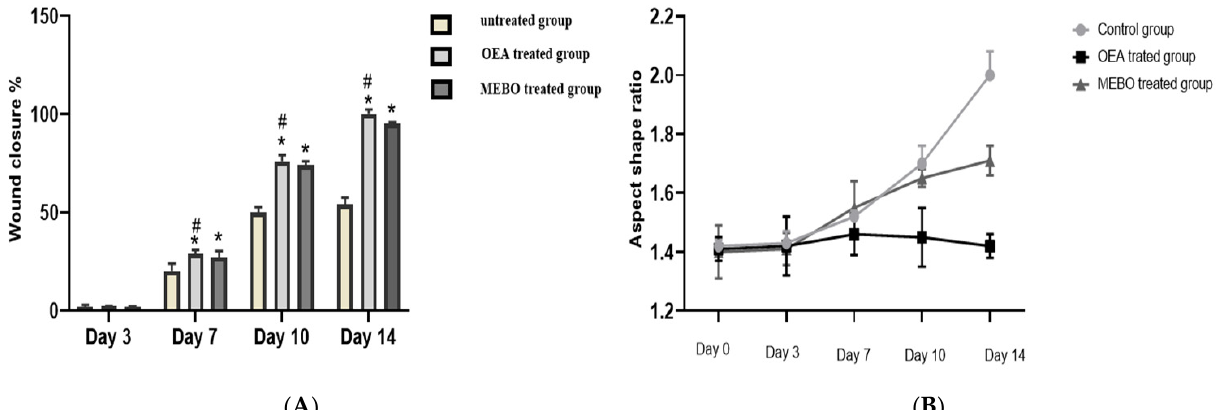
Figure 6. ( A ) Percentages of wound closure in all groups of the study ( n = 6) with time after injury (0, 3, 7, 10, and 14 days). A two-way ANOVA test was performed to evaluate whether there was a significant difference between the groups. The data is presented as the mean ± SD. * p < 0.05 compared to the untreated group on the same day, and # p < 0.05 compared to the MEBO® group on the same day. ( B ) To clarify observed differences in the shape and direction of wound contraction between groups, the wound aspect ratio was calculated (length: width).